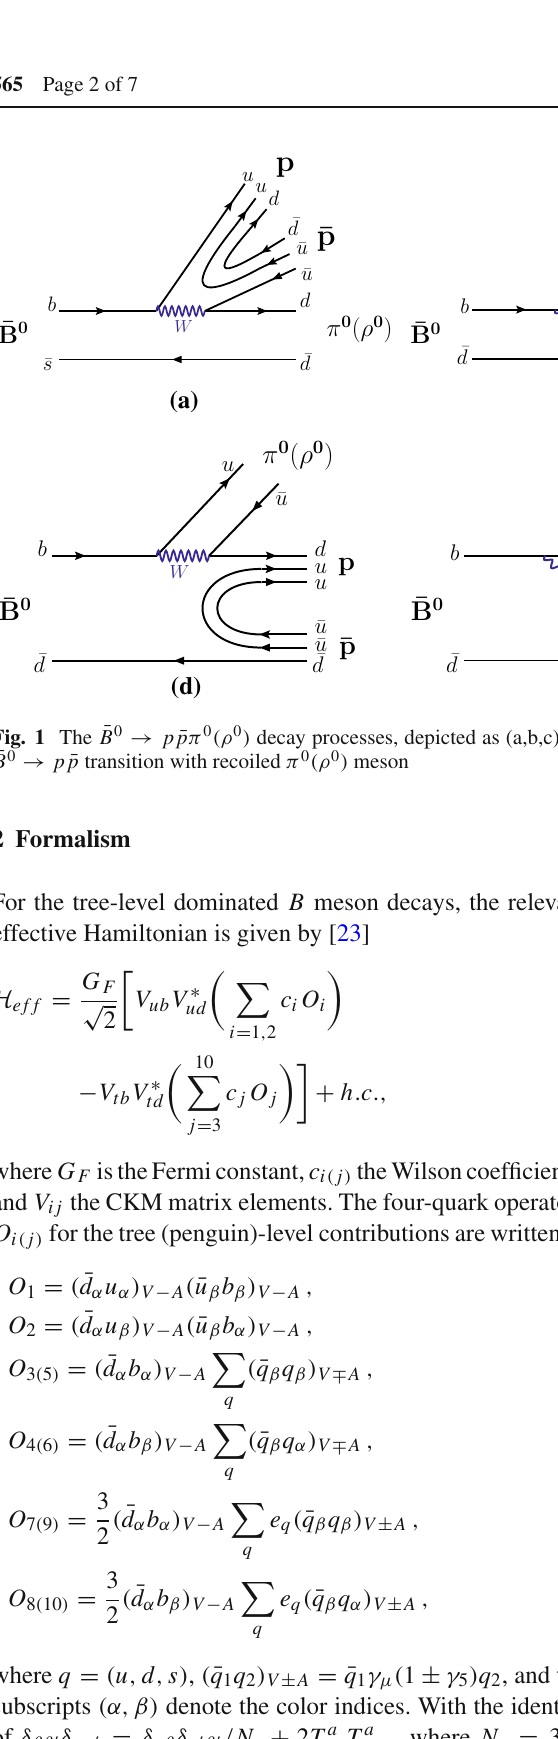
in Fig. 2 for the b → u ¯ ud transition, dynamically, the d